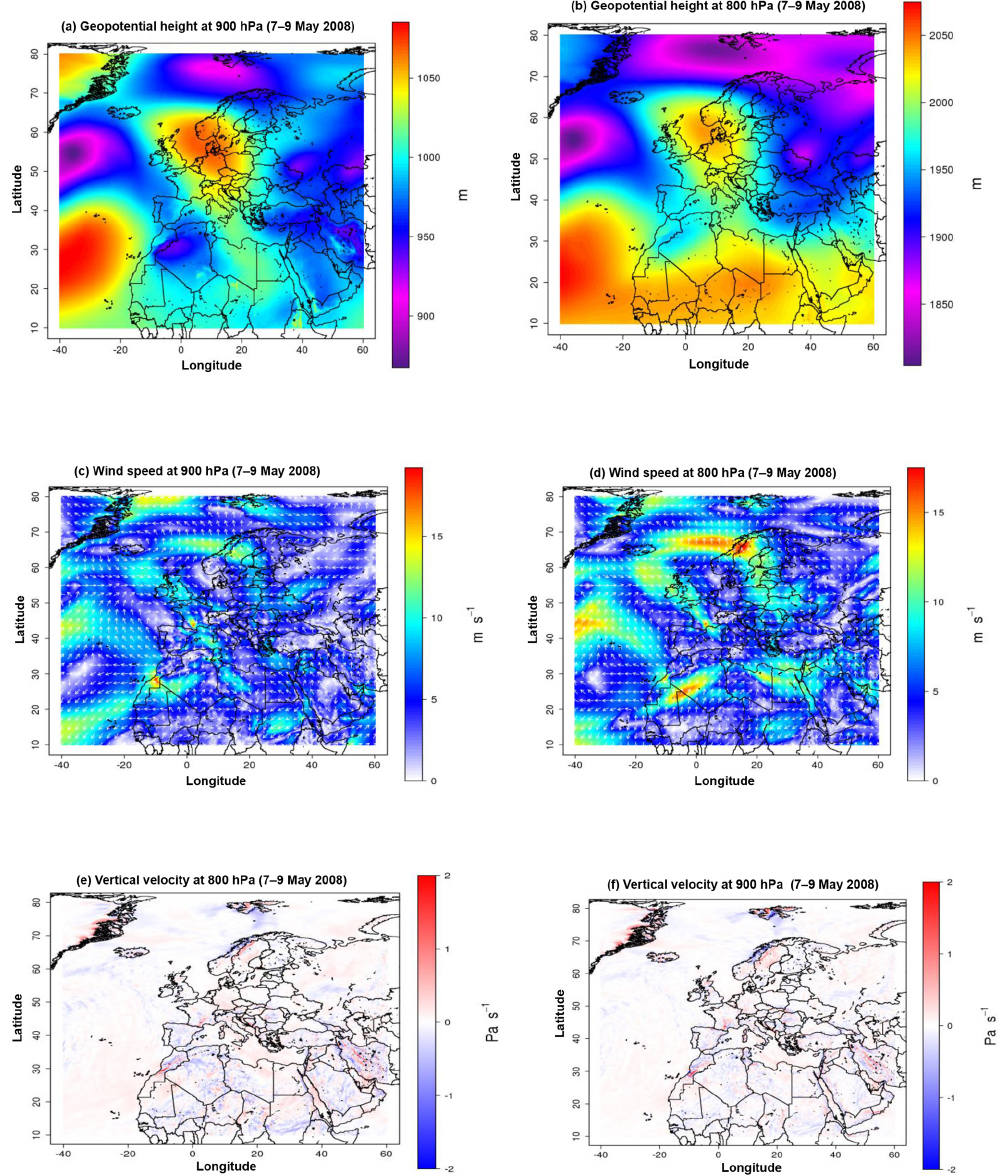
Figure 8. Composite ECMWF meteorological charts of geopotential height ( a, b ; in m), wind speed ( c, d ; in ms − 1 ) and vertical velocity ( e, f ; in Pas − 1 ) at 900hPa (left) and 800hPa (right) for the high ozone episode of 7–9 May